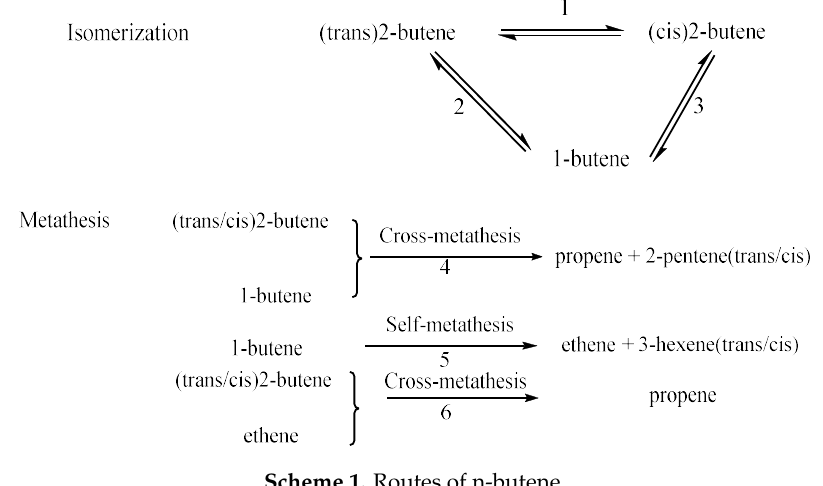
Scheme 1. Routes of n-butene.